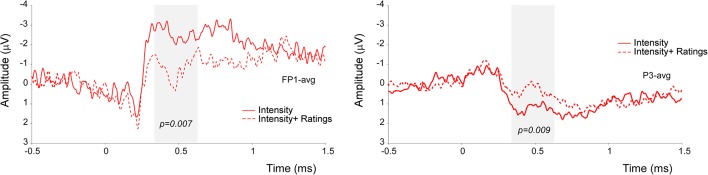
Results of the non-parametric cluster-based permutation test in the time-domain. The signal in the Intensity condition was significantly more negative at the FP1 electrode, and significantly more positive at the P3 electrode.